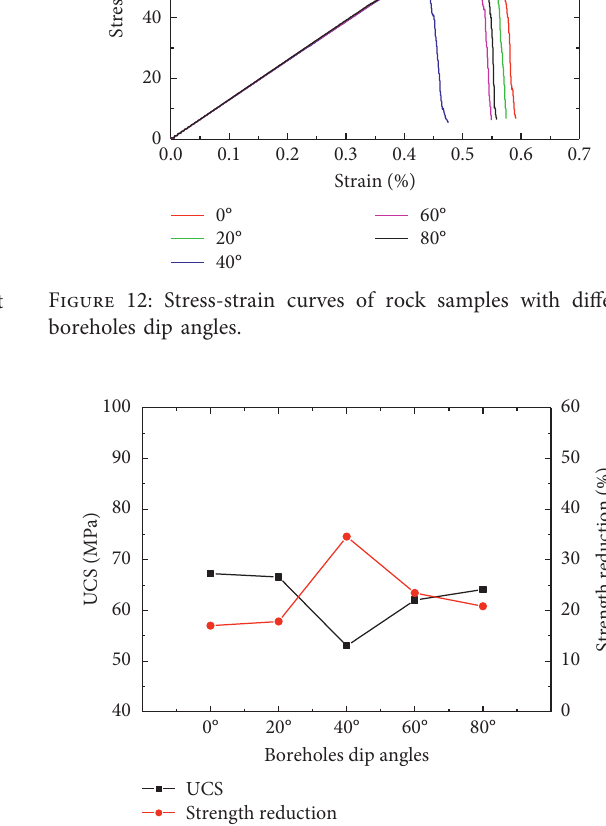
Figure 13: Strength reduction curves of rock samples with different boreholes dip